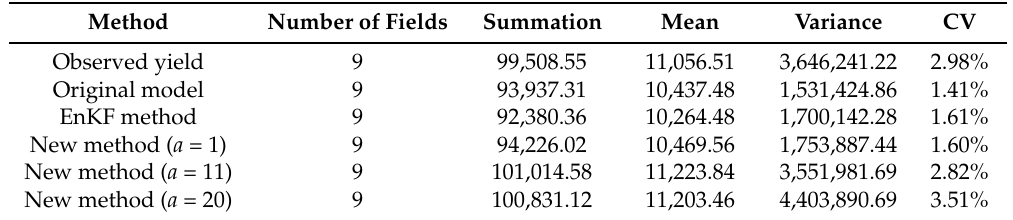
Table 13. Spatial heterogeneity of yield simulation results within fields